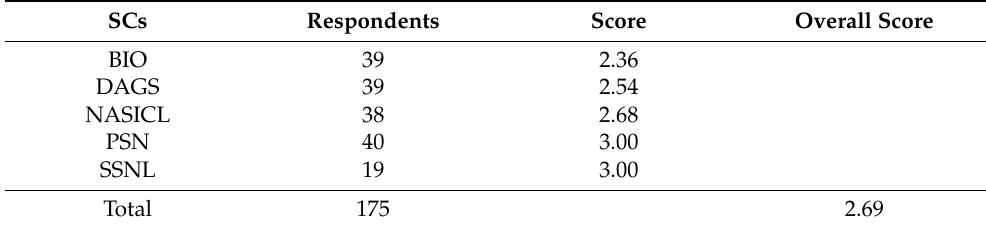
Table 4. Behavioral change of